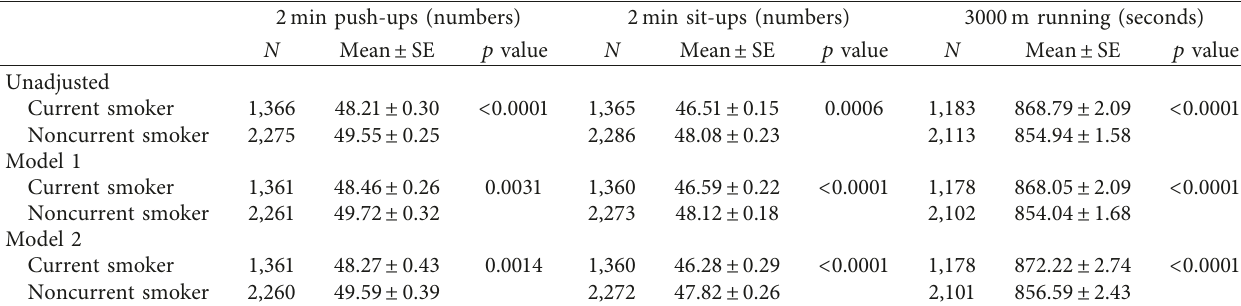
Table 2: Difference in each exercise performance between current smoker and noncurrent smoker.